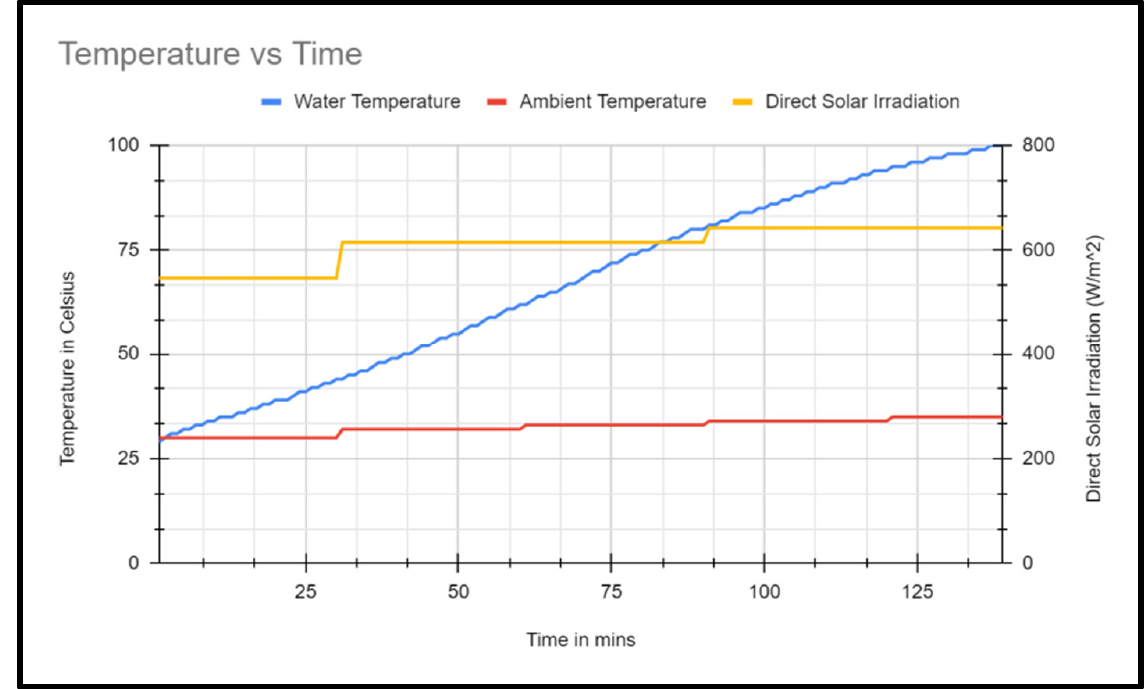
Figure 11. Temperature and irradiation values from day 5 using water as the test load for the second figure of merit.